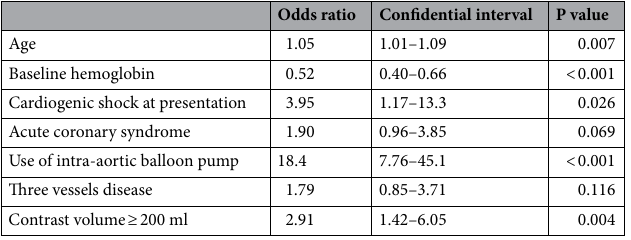
Table 5. Multivariable logistic regression model of the primary endpoint.